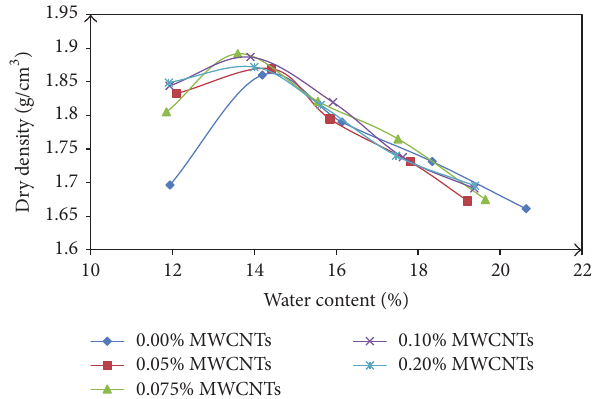
Figure 9: Compaction curves for treated UKM soil with MWCNTs.